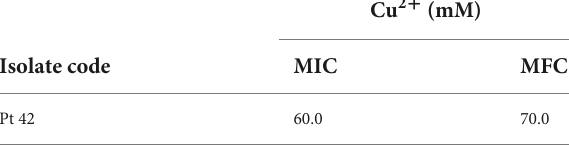
FIGURE3 Agar diffusion test. Inhibition halos of mycelium growth of Plenodomus tracheiphilus induced by copper sulfate solution at